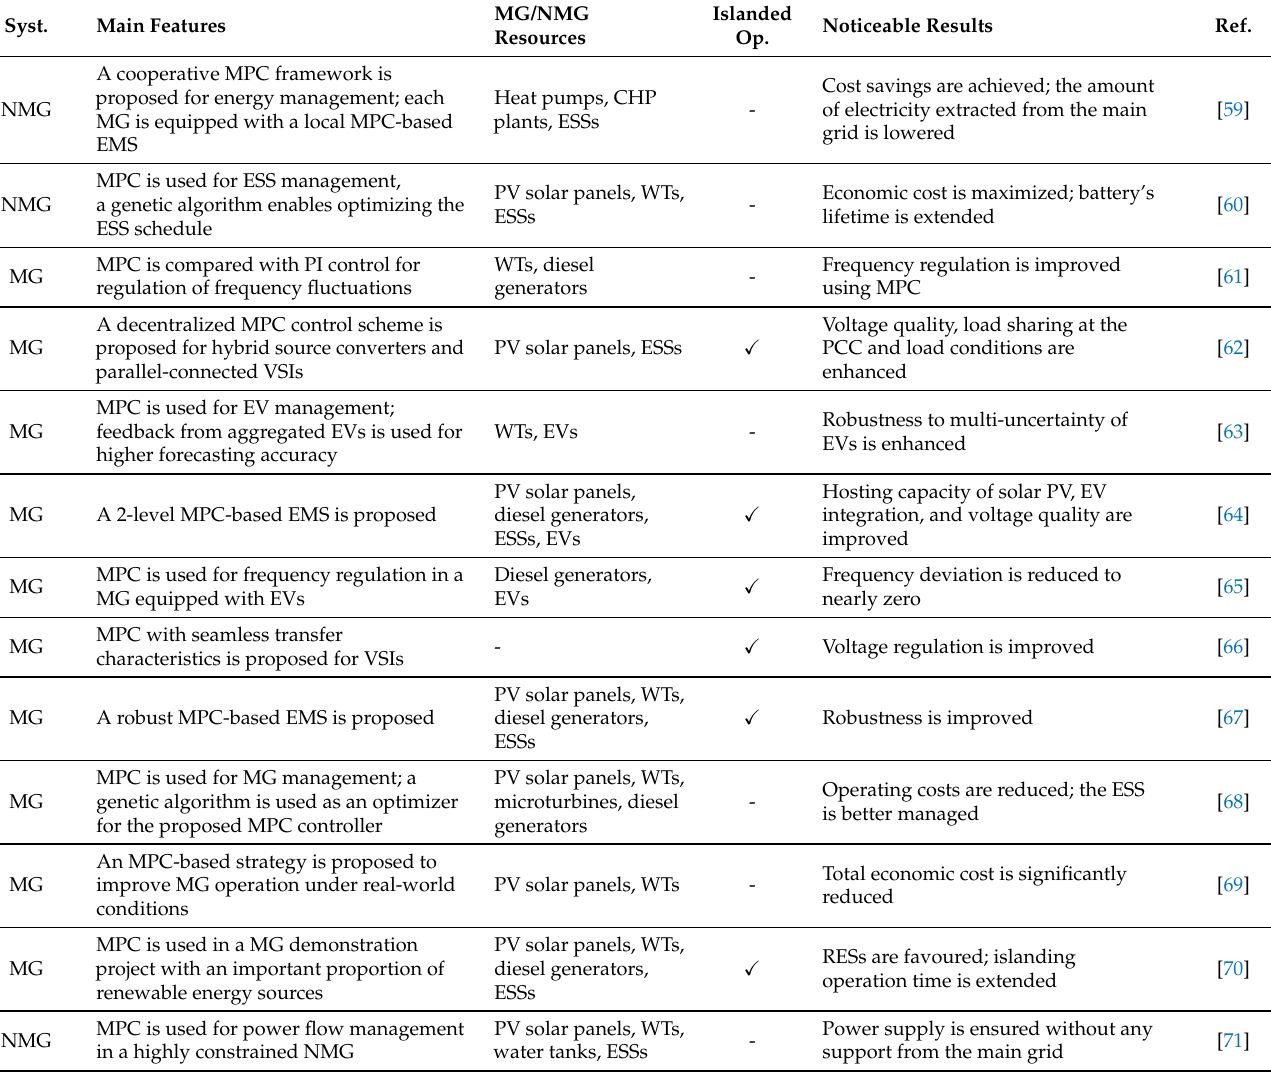
Table 3. A focus on papers dealing with model-based predictive control (MPC) for MG/NMG management. CHP stands for combined heat and power. EMS stands for energy management system. ESS stands for energy storage system. MG stands for microgrid. NMG stands for networked microgrid. PCC stands for point of common coupling. PI stands for proportional integral. RES stands for Renewable energy source. VSI stands for voltage-source inverter. WT stands for wind